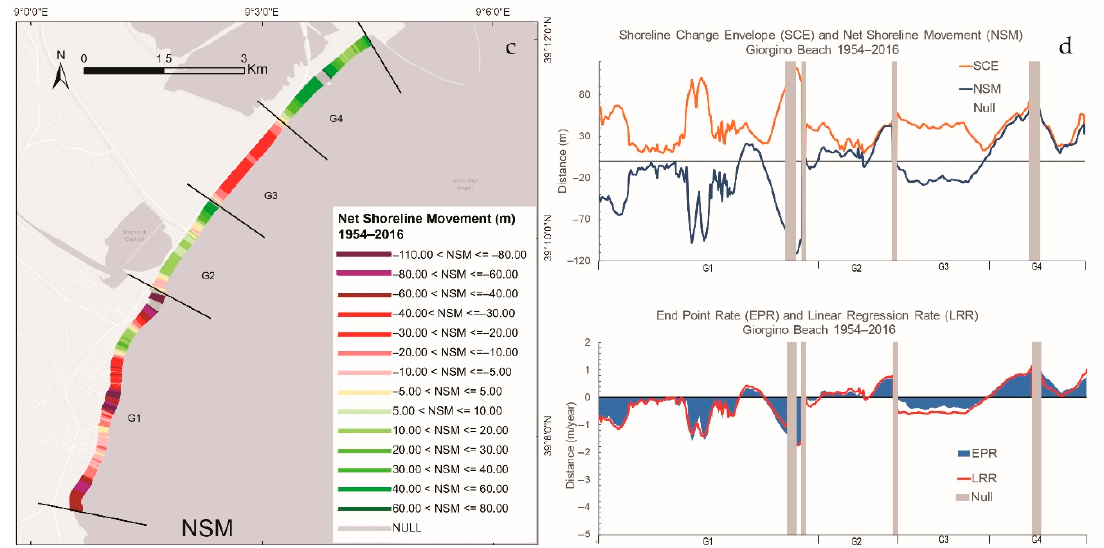
Figure 7. Maps showing the spatial distribution of shoreline change envelope (SCE) ( a ), end point rate (EPR) ( b ) and net shoreline movement (NSM) ( c ) along the Giorgino beach for the years 1954–2016, superimposed with the limits of the four discriminated sectors (G1–G4); SCE, NSM, EPR and LRR trends ( d ) plotted against distance (west to east), with the x-axis showing the limits of the G1–G4 sectors. Positive values of NSM and EPR indicate areas of accretion, whilst negative values indicate areas of shoreline retreat.